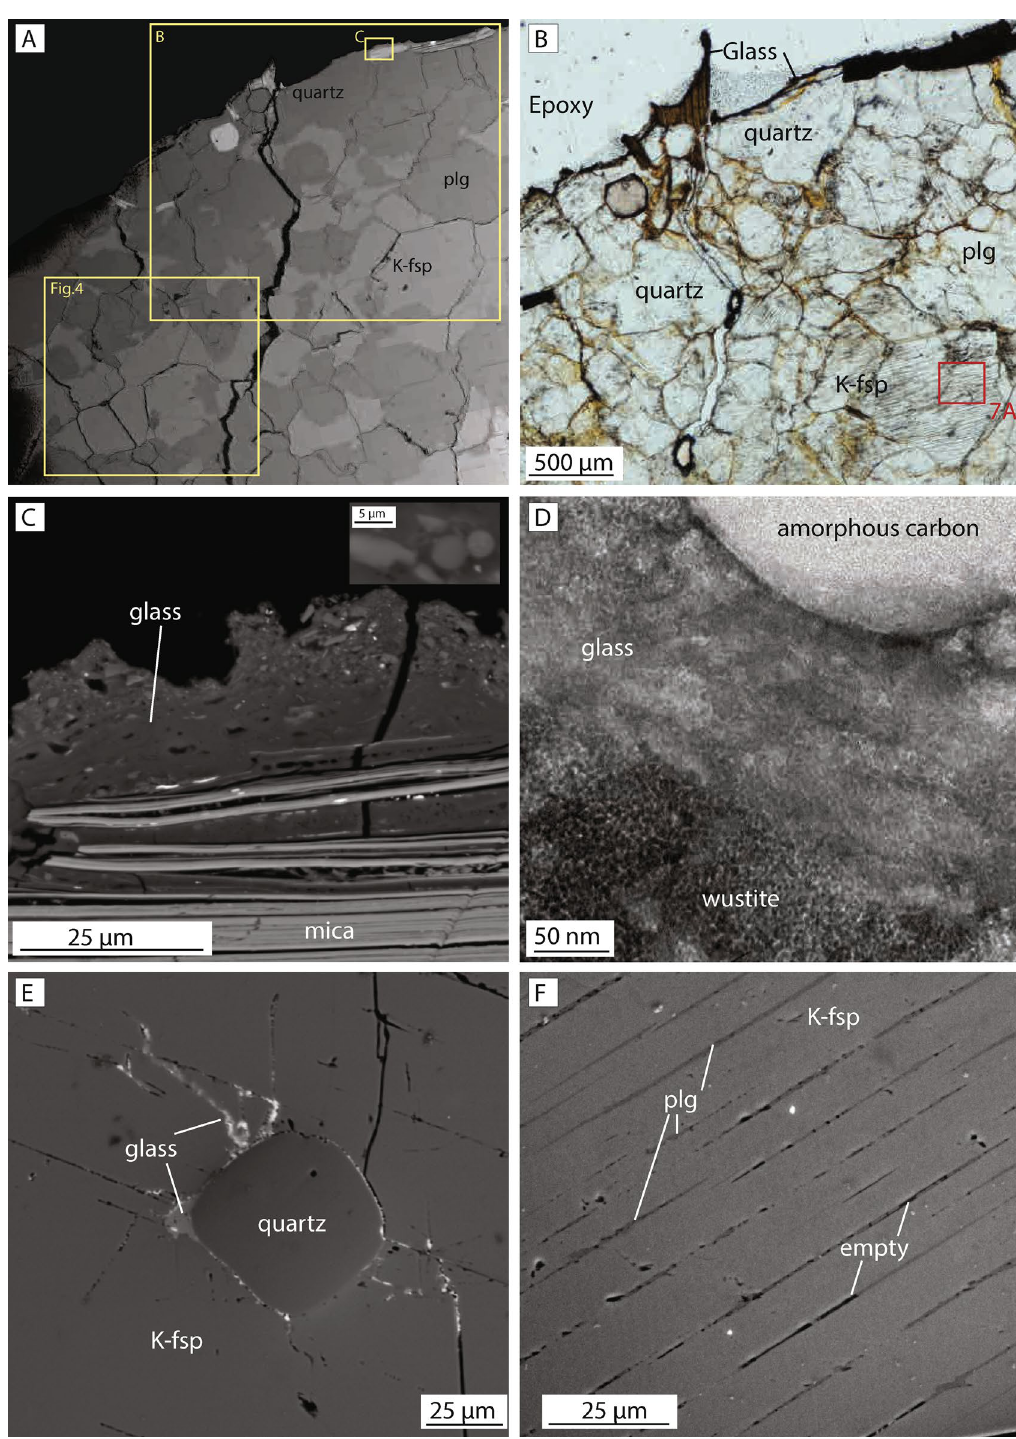
Figure 3. Microstructural characteristics of surface fulgurite sample. (A) Overview SEM backscatter image shows the distribution of quartz and plagioclase and K-feldspar, and the locations of images ( B,C and Fig. 4). (B) Optical microscope image (plane polarized light) shows the surface glass and underlying quartz and K-feldspar with planar exsolution lamellae. Location of in-situ synchrotron Laue diffraction analysis is indicated by red box (C) SEM image shows the glassy surface crust and infiltration of glass along the cleavage surfaces of biotite. (D) Transmission electron microscope brightfield images show the coexistence of granular wüstite and amorphous carbon in an amorphous matrix in the fulgurite on the surface. Only the amorphous glassy matrix (in the limited observed area) was observed in the fracture-related fulgurite. (E) Thin layer of Si-rich glass forming around a quartz grain enclosed in K-feldspar with exsolution lamellae. (F) Detail of parallel, closely spaced planar structures found in K-feldspar, interpreted in the text as exsolution lamellae of